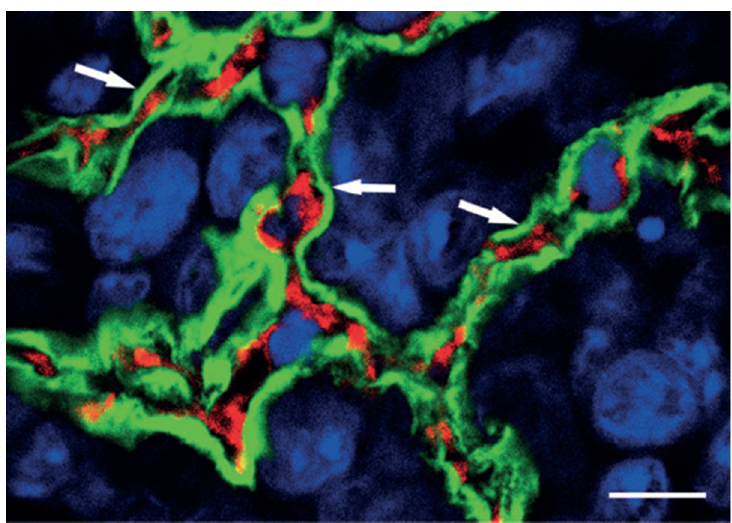
Figure 2. Preservation of alveolar architecture in the peripheral regions of lung metastases that is indicative of vessel co-option. Experimental lung metastases are generated by injecting HT1080 cells intravenously into SCID mice. After extravasation and forming small interstitial colonies, tumor cells enter the alveolar air spaces. This high-power confocal micrograph of the periphery of an HT1080 lung metastasis has been stained for podoplanin (green), CD31 (red), and with TOTO-3 (blue), which highlights the tumor mass. Note that intact alveolar walls with regular layering (pneumocyte–capillary–pneumocyte) are present (arrows). Scale bar = 10 μm. (Reproduced from [52]).